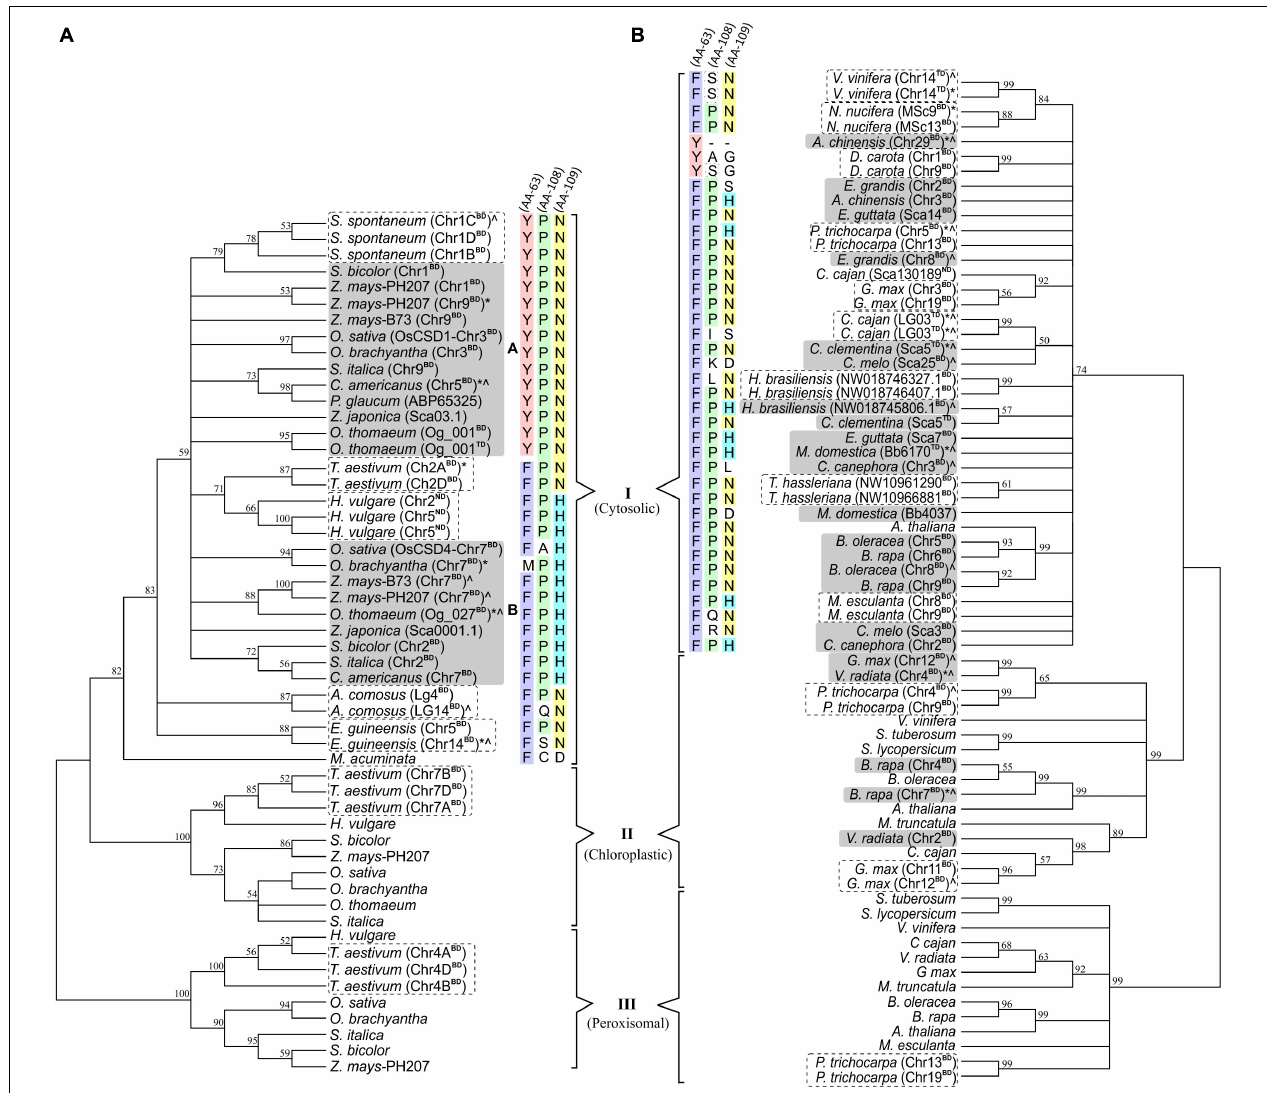
FIGURE 11 | Phylogenetic analysis of cytosolic, chloroplastic, and peroxisomal CSDs (including duplicate copies) among monocots (A) and dicots (B) using neighbor-joining algorithm (pairwise-deletion option) in the MEGA software. Clusters specific to cytosolic (I), chloroplastic (II), and peroxisomal (III) CSD isoforms are indicated, and the numbers at the nodes represent bootstrap values (in%) for a 500-replicate analysis. Taxa designation includes the species name followed by chromosomal designation and duplication type (BD: block duplication and TD: tandem duplication) in parenthesis and symbols indicating extent of variation (“*” variation in SOD domain/important features; “ˆ” variation due to indels). Conservation of amino acid residues at three important positions (63 in Loop IV; 108 and 109 in Loop VI) are shown with different color codes for cytosolic CSD copies in monocots and